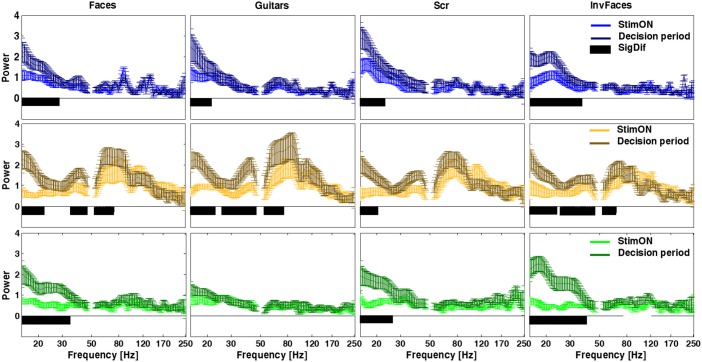
Analysis of Power per electrode cluster and condition reveals a temporal pattern of differences in power, with anterior object recognition regions showing increased decision related low frequency activity patterns.Cluster averaged power is plotted with standard deviation. Notably lower frequency band activation emerges after stimulus offset (decision period) for the more anterior electrodes (“green” and “blue”). Color lines (horizontal panels) represent the three clusters of electrodes. The more posterior channels (“orange” labels) have the main pattern increase at high gamma in contrast to the other locations. Black bars in the plots indicate the significant differences between time-windows (p<0.0065; detailed statistical values are reported in Table A in S1 file). No difference was found across stimuli conditions, suggesting that the observed regional patterns reflect a general object recognition mechanism.